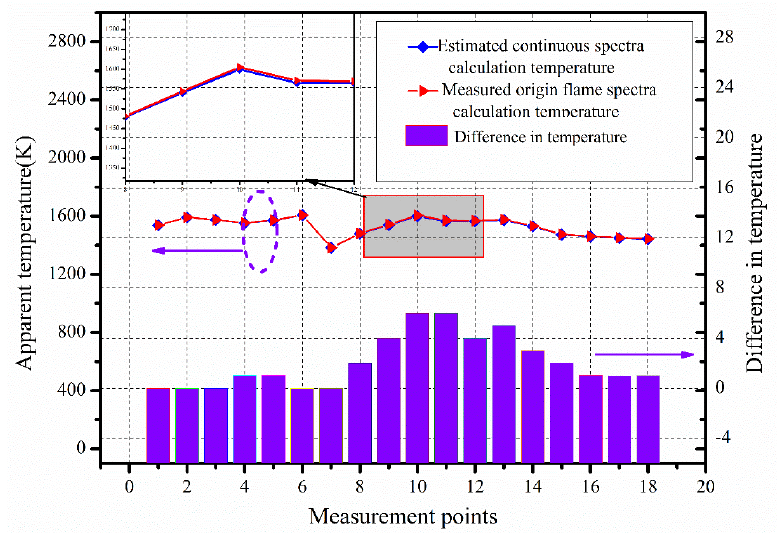
Figure 11. Influence of radiation intensity of discontinuous emission spectra on the temperature calculation.